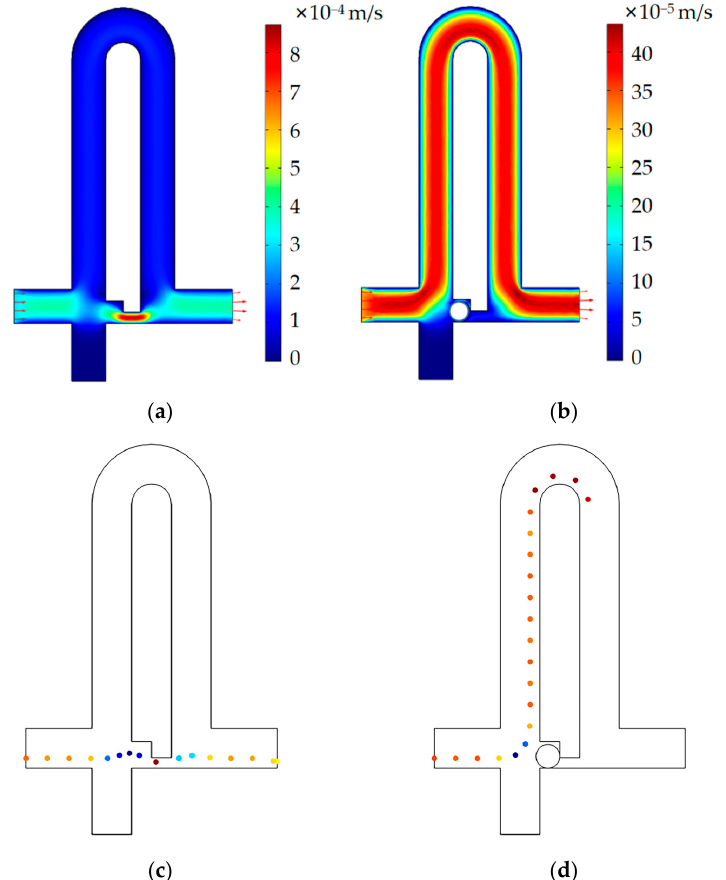
Figure 6. The function of the isolation module is veri fi ed by numerical simulation. ( a ) The velocity pro fi le of a single-cell functional module without cell capture; ( b ) the velocity pro fi le of a single-cell functional module with cell capture. ( c ) When the capture channel is vacant, the particles preferen- tially fl ow to the capture channel because the fl ow resistance of the capture channel is smaller than that of the bypass channel. ( d ) When the capture channel captures the cell, the fl ow resistance of the capture channel suddenly increases, and the particles preferentially fl ow to the bypass